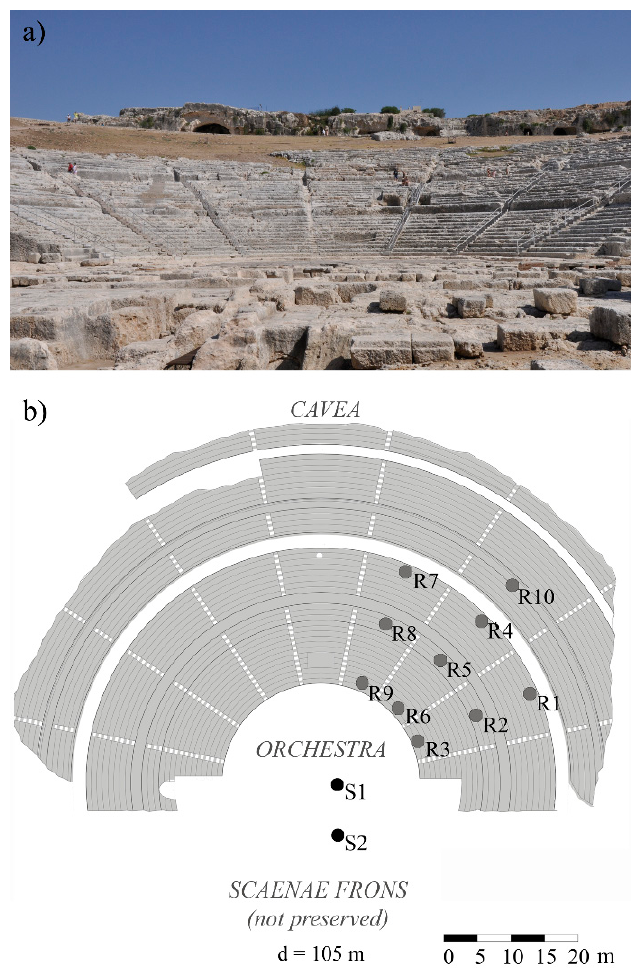
Figure 1. Present conditions of the ancient theatre of Syracusae ( a ) and measurement set-up ( b ). S1 and S2 represent the source positions. R1 to R10 indicate the receiver positions.